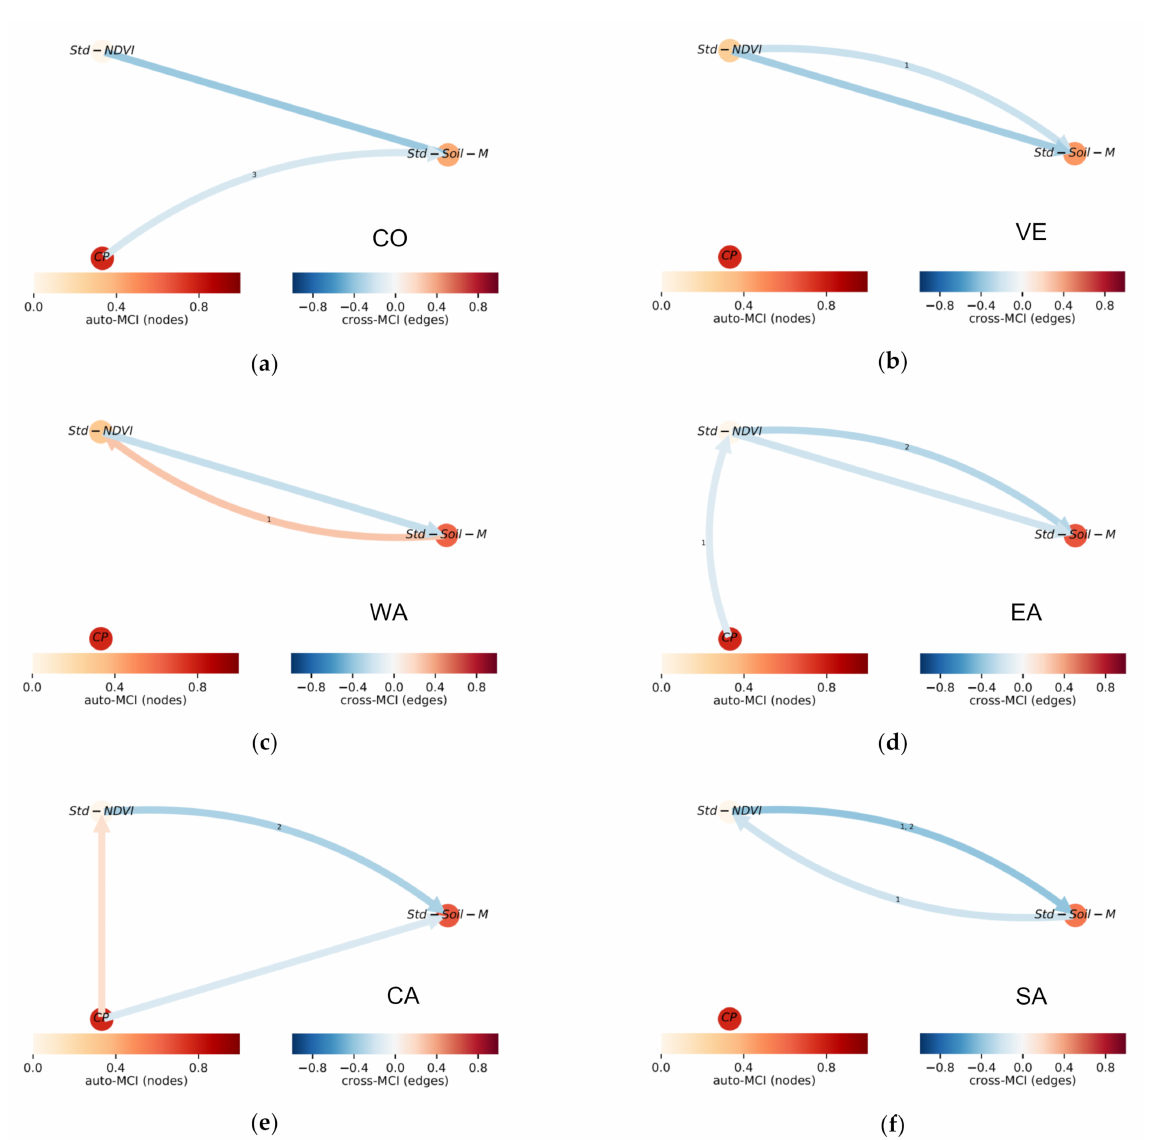
Figure 12. Nonlinear causality analysis based on PCMCIplus between the standardized monthly series of NDVI and SMOS, and the Central Pacific (CP) index. Node colors denote the nonlinear auto-dependency of each variable, whereas the colors of the lines denote the cross-MCI between both variables and the horizontal lines denotes the simultaneous nonlinear co-dependency. ( a ) CO: Colombia, ( b ) VE: Venezuela, ( c ) WA: West Amazonia, ( d ) EA: East Amazonia, ( e ) CA: Center Amazonia, and ( f ) SA: South